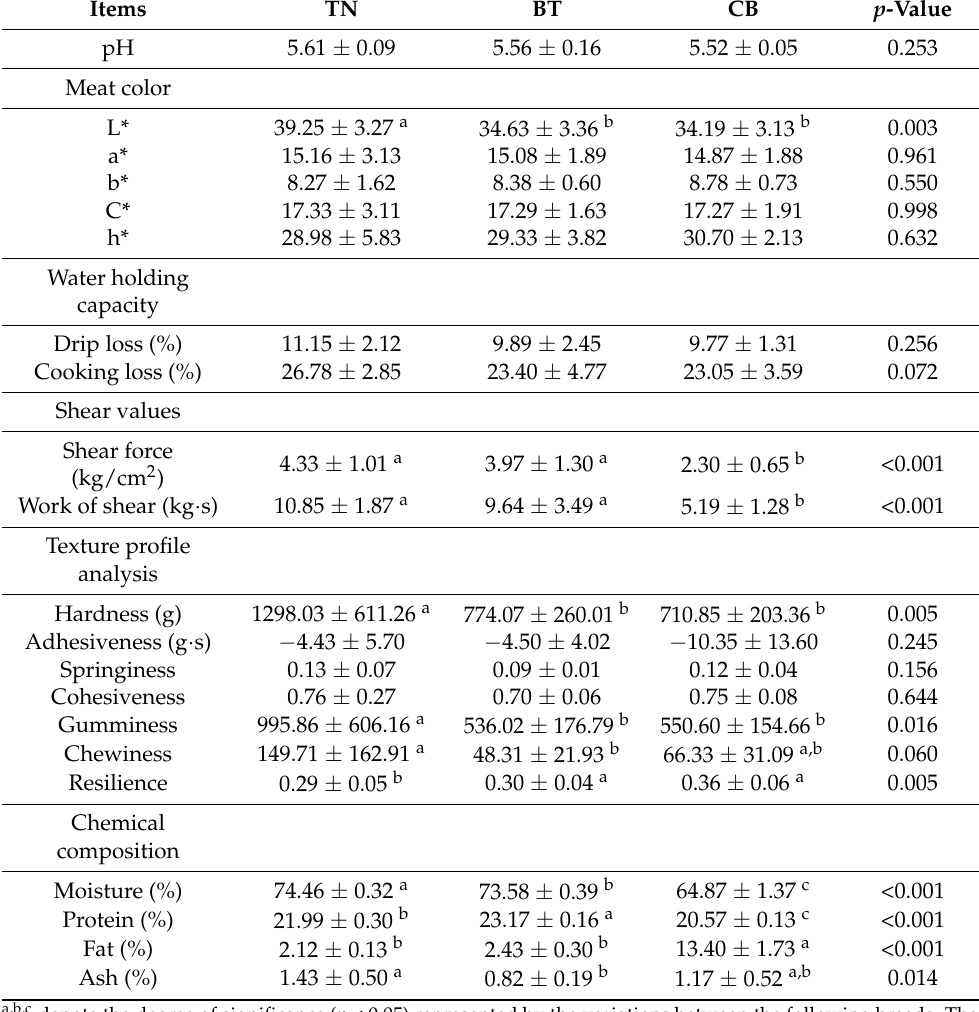
Table 1. Physicochemical characteristics of beef loins (M. Longissimus dorsi) from different breeds.